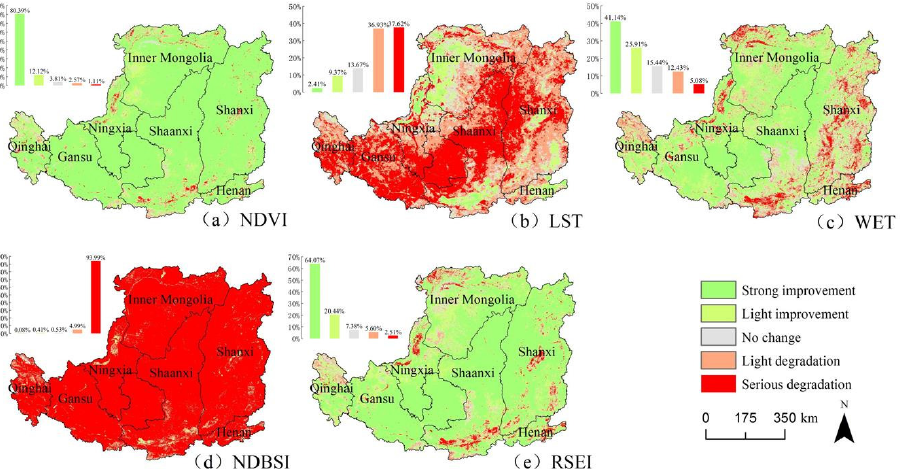
Figure 7. Changing trends of each indicator: ( a ) changing trends of NDVI; ( b ) changing trends of LST; ( c ) changing trends of WET; ( d ) changing trends of NDBSI; ( e ) changing trends of NDBSI. Mongolia, northern Ningxia and southern Shaanxi (Figure 7e). The majority (84.51%)